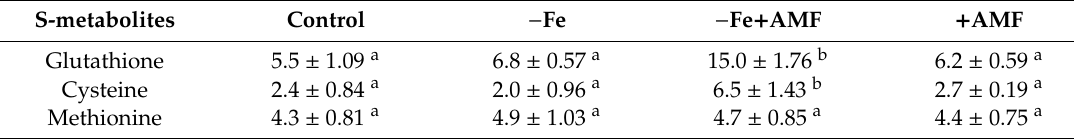
Table 2. S-metabolites ( µ g g − 1 FW) in root of alfalfa cultivated under Fe deficiency ( − Fe) with or without AMF. Data represent means ± SD ( n = 3). Di ff erent letters above the tabulated values indicate significant di ff erence at p < 0.05 level.